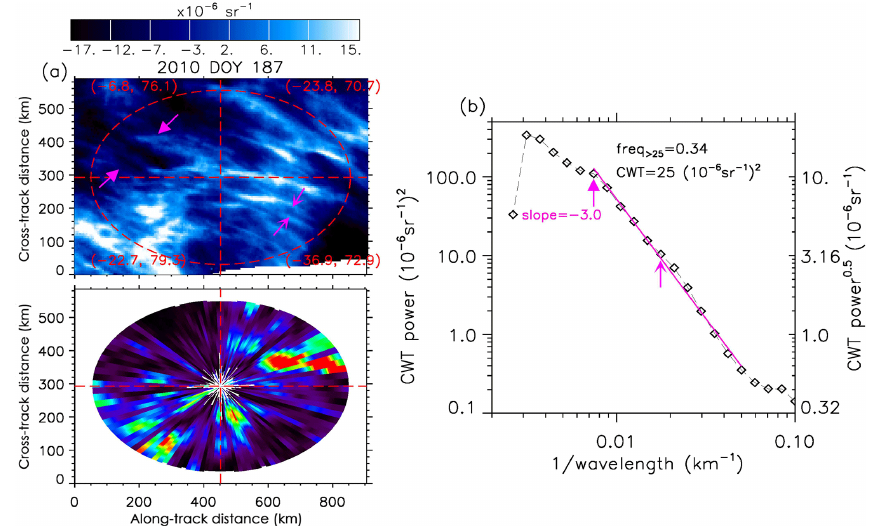
Figure 11. Demonstration of longer and shorter waves nested together. (a) The albedo map and the corresponding albedo power map. The longer waves are roughly at ∼ 150km wavelengths (between solid arrows), and the shorter waves are roughly at ∼ 40km wavelengths (between thin arrows). (b) The albedo power spectra with an exponent of − 3.0.